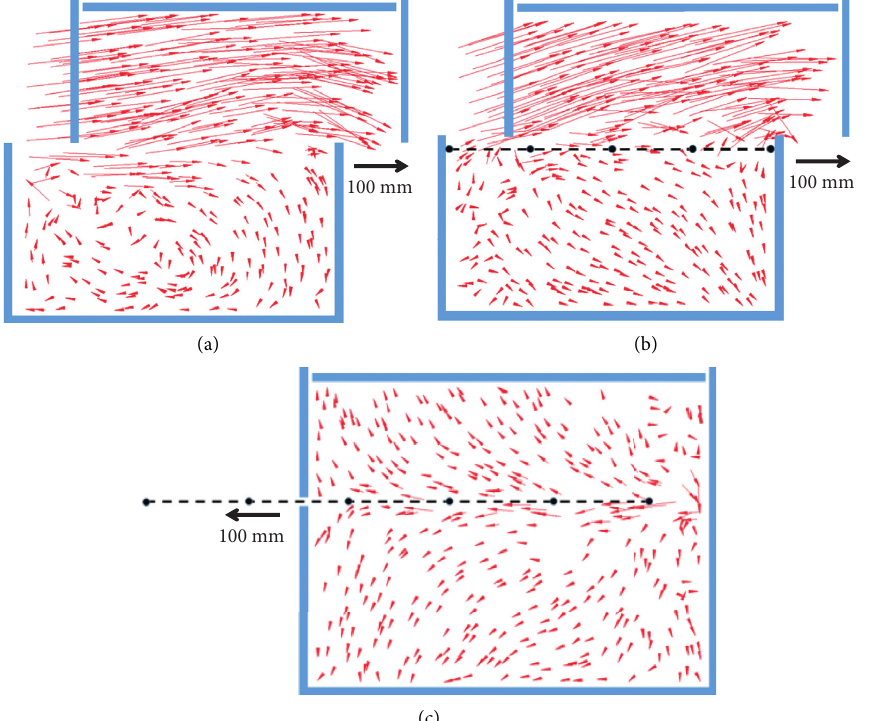
Figure 7: Particle displacements. (a) Direct shear of unreinforced specimen. (b) Direct shear of reinforced specimen. (c) Pull-out test.